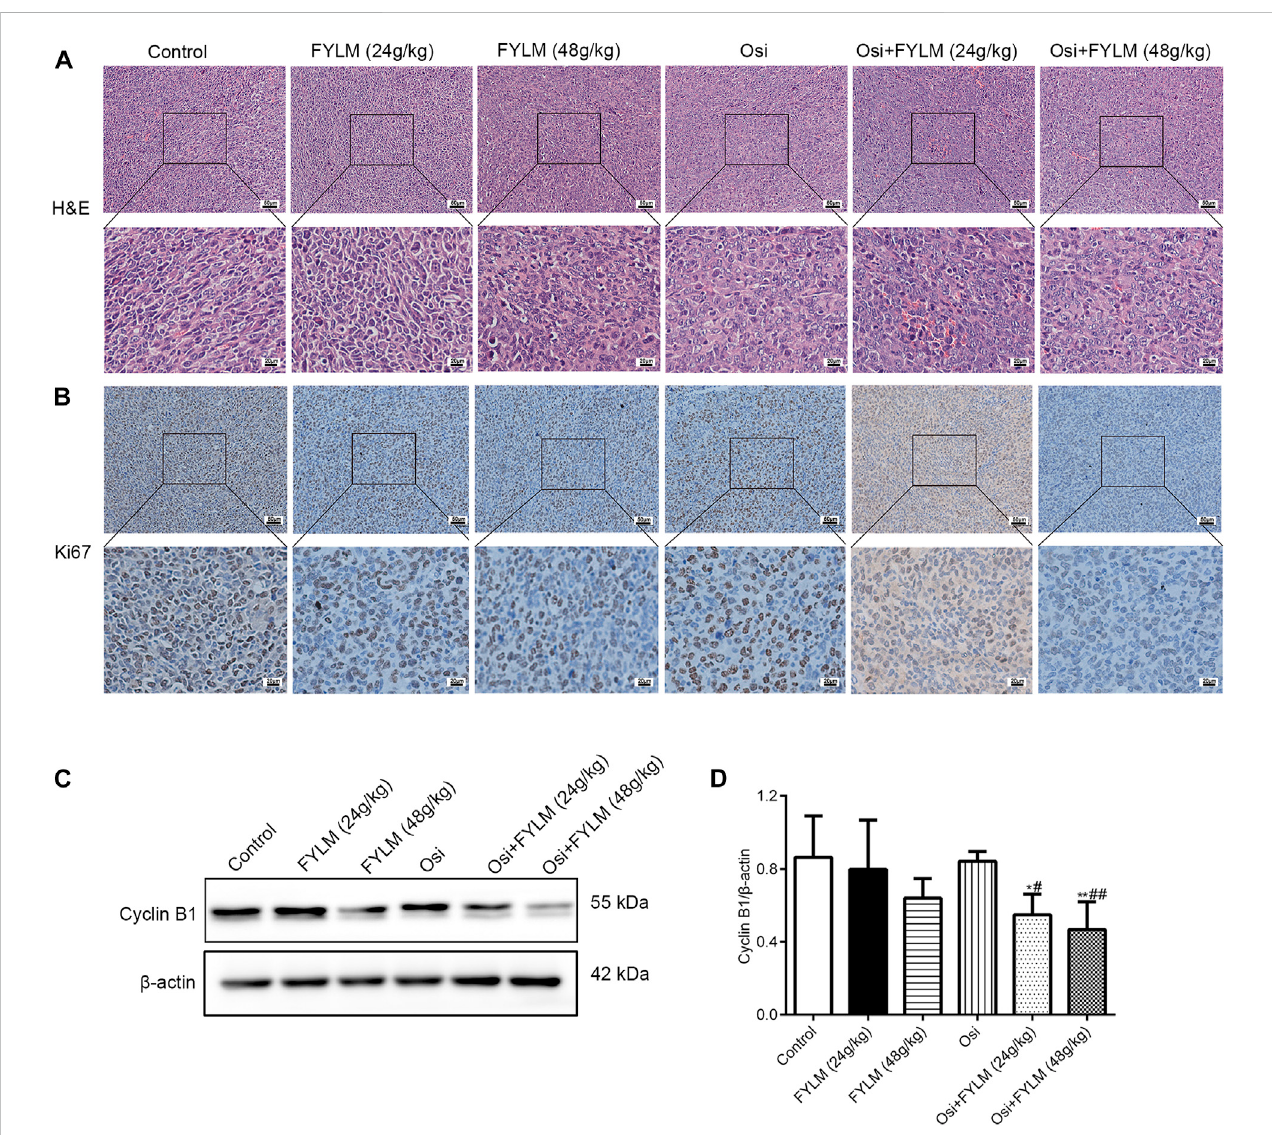
FIGURE 5 FYLM combined with osimertinib regulates cell proliferation and cell cycle in EGFR-Del19/T790M/C797S LLC tumor-bearing mice. (A) HE staining of tumor tissues. (B) Detection of Ki67 expression in tumor tissues by immunohistochemistry. (C) Cyclin B1 proteins were detected by western blotting. (D) Quantitative analysis of Cyclin B1 protein levels. * p < 0.05 and ** p < 0.01 vs. Control; # p < 0.05 and ## p < 0.01 vs. Osi. Osi, osimertinib. All data are shown as mean ±